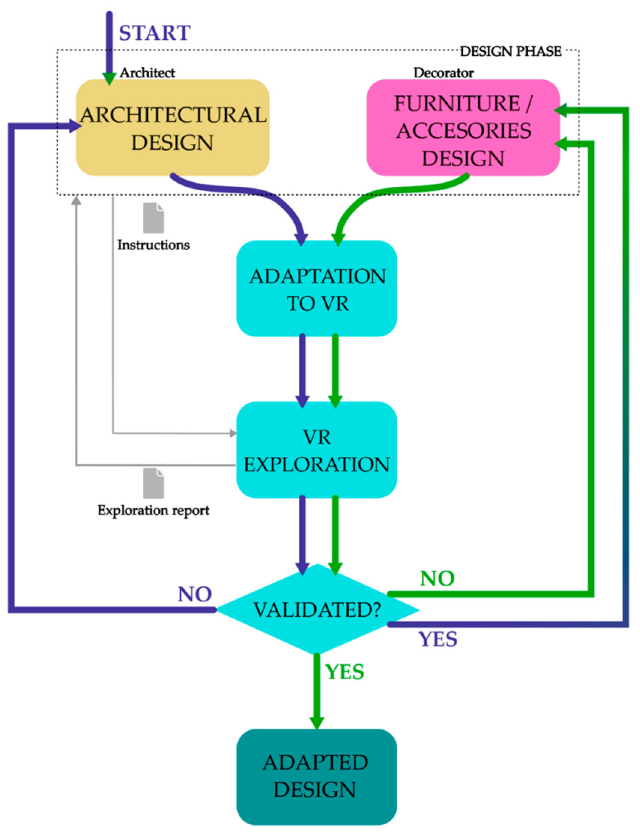
Figure 1. Workflow of the proposed method for the wheelchair user assisted design.